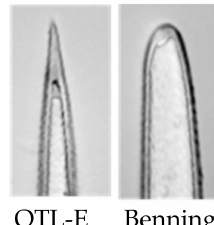
Figure 4. Trichomes of QTL E in the Benning background have sharp tip shape, whereas insect- susceptible Benning does